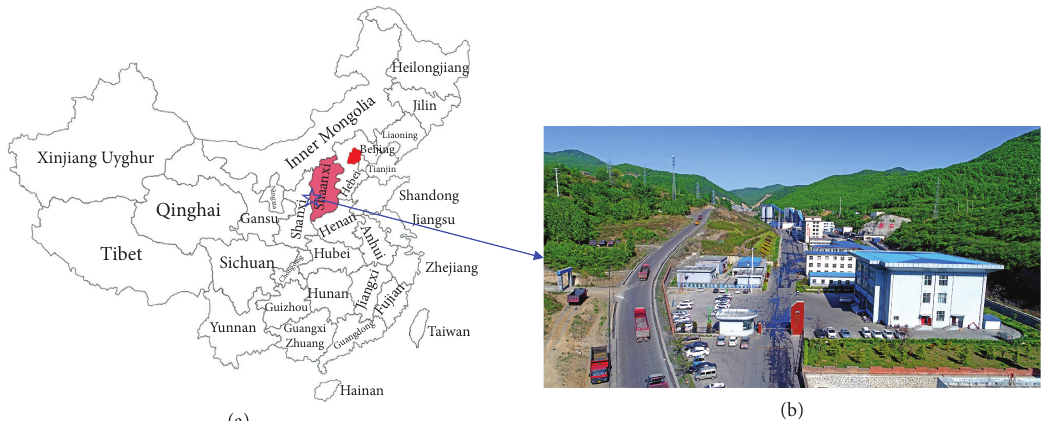
Figure 7: Location and appearance of the test mine (Shanxi Yixin coal